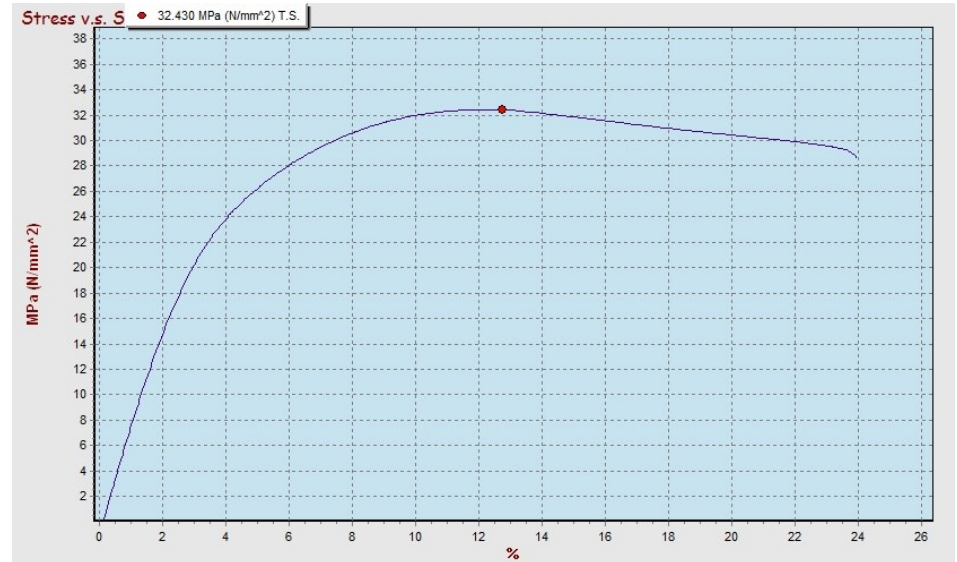
Figure 12. Stress–strain relationship in the tensile test of PP–SBT composite with 30 vf% and 250 mesh particle size.